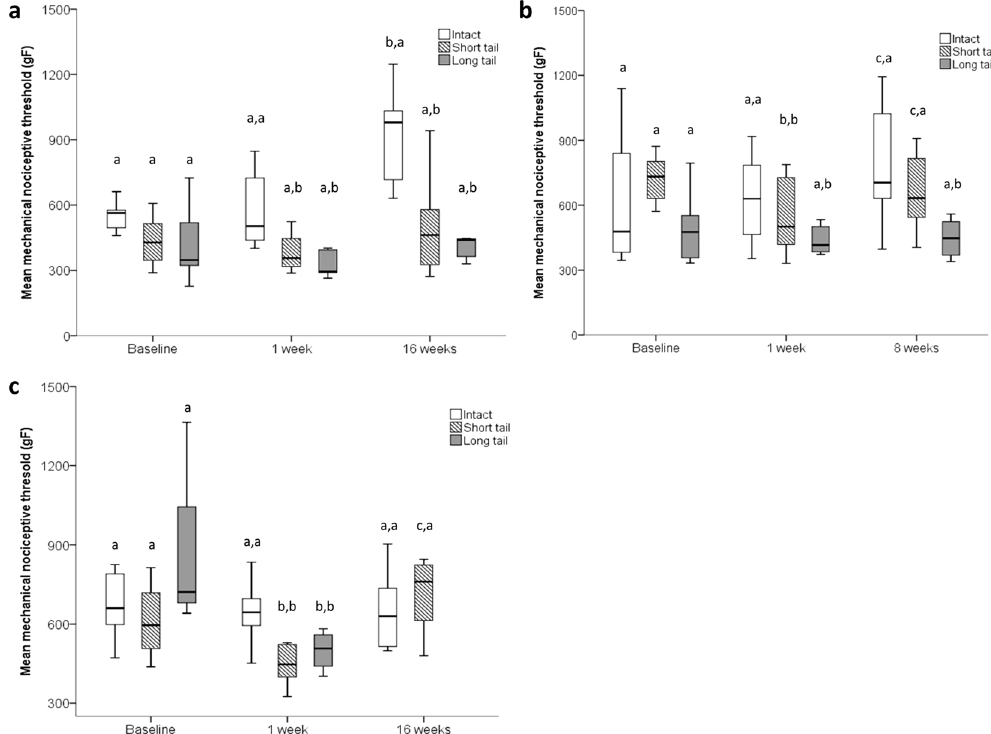
Figure 2. Temporal profile of sensitisation following surgery. Time course of changes in mean mechanical nociceptive thresholds ( ± SEM) recorded at the site of tail resection across three tail-resection treatments. ( a ) Surgery performed in pigs of 9 weeks of age and MNTs assessed 3 days pre-, 1 week and 16 weeks post-surgery; ( b ) Surgery performed in pigs of 17 weeks of age and MNTs assessed 3 days pre-, 1 week and 8 weeks post- surgery; ( c ) Surgery performed in pigs of 17 weeks of age and MNTs assessed 3 days pre-, 1 week and 16 weeks post-surgery. The vertical bars denote the 25th to 75 th and the whiskers 5th to 95 th percentile ranges. Different first letters indicate significant difference vs. the previous time point; different second letters indicate significant difference between tail-resection treatment within the same time point (P <